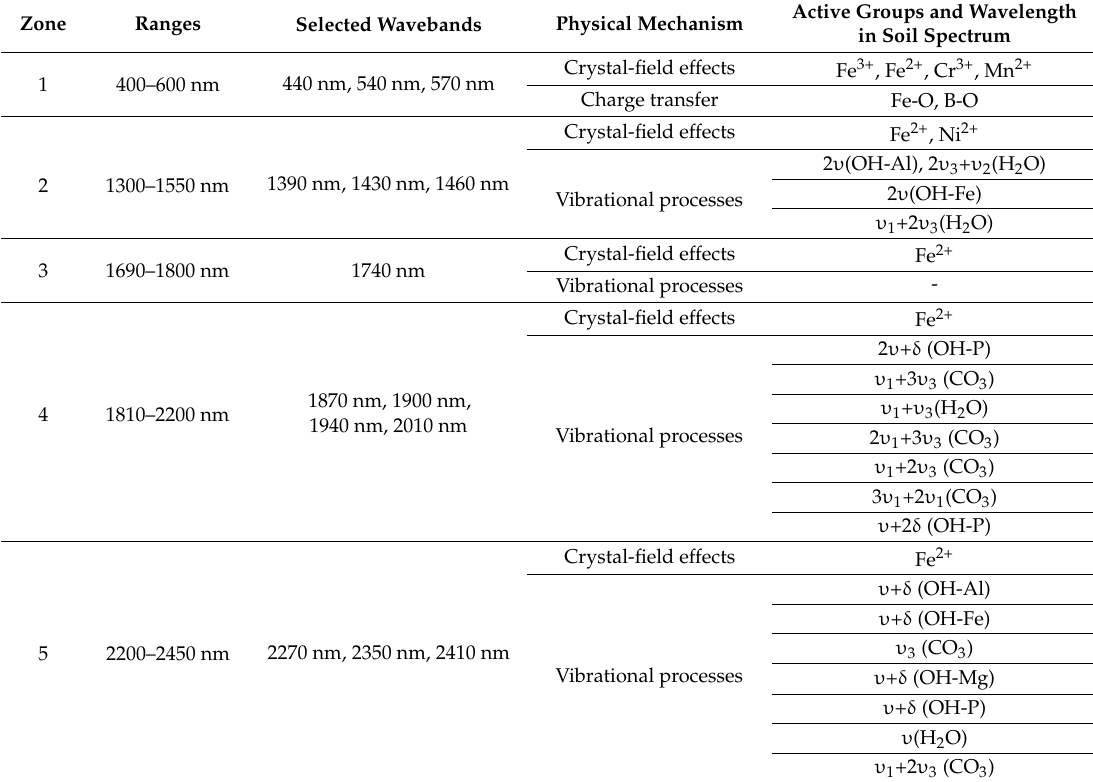
Table 3 . Selected wavebands based on hyperspectral PCAr results along with reported corresponding active groups with physical mechanisms [38].